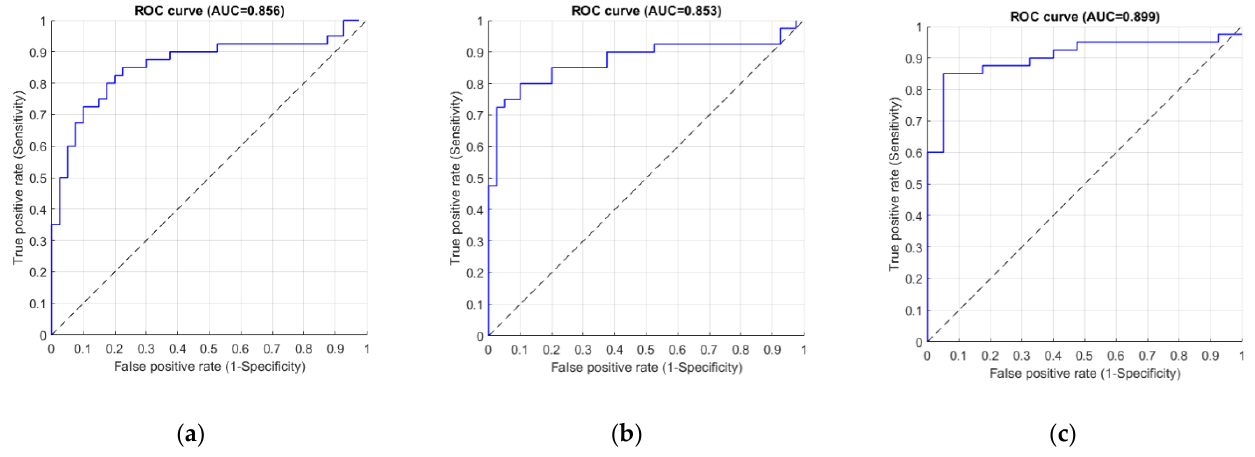
Figure 7. The ROC curves of different CNN models: ( a ) Inception v4 ( b ) Inception ResNet v2 ( c ) DenseNet-121. The x -axis false positive rate (or 1-specificity) and the y -axis denotestrue positive rate (or sensitivity). The dot line indicates the overall trend.